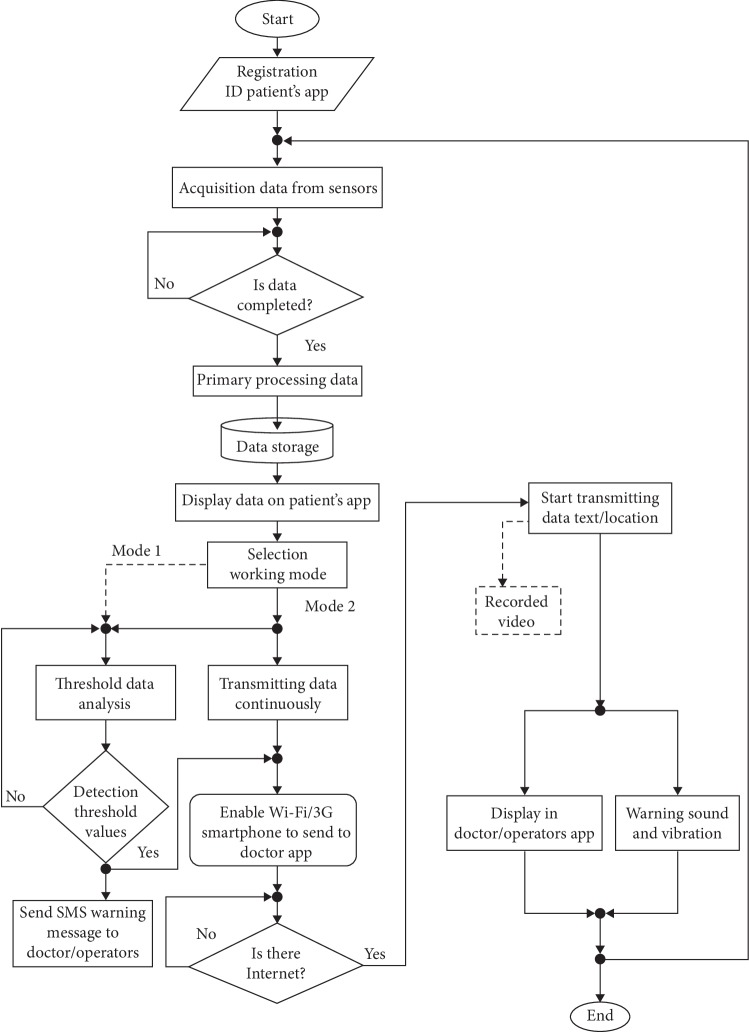
Flowchart of the working mechanism of the designed system.